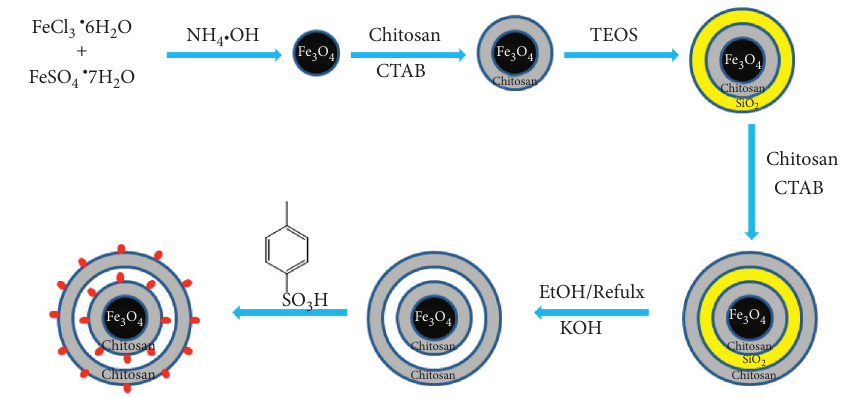
Figure 7: Synthesis of the FCHC-SO 3 H catalyst. Reproduced with permission from [48] copyright 2018, Elsevier.